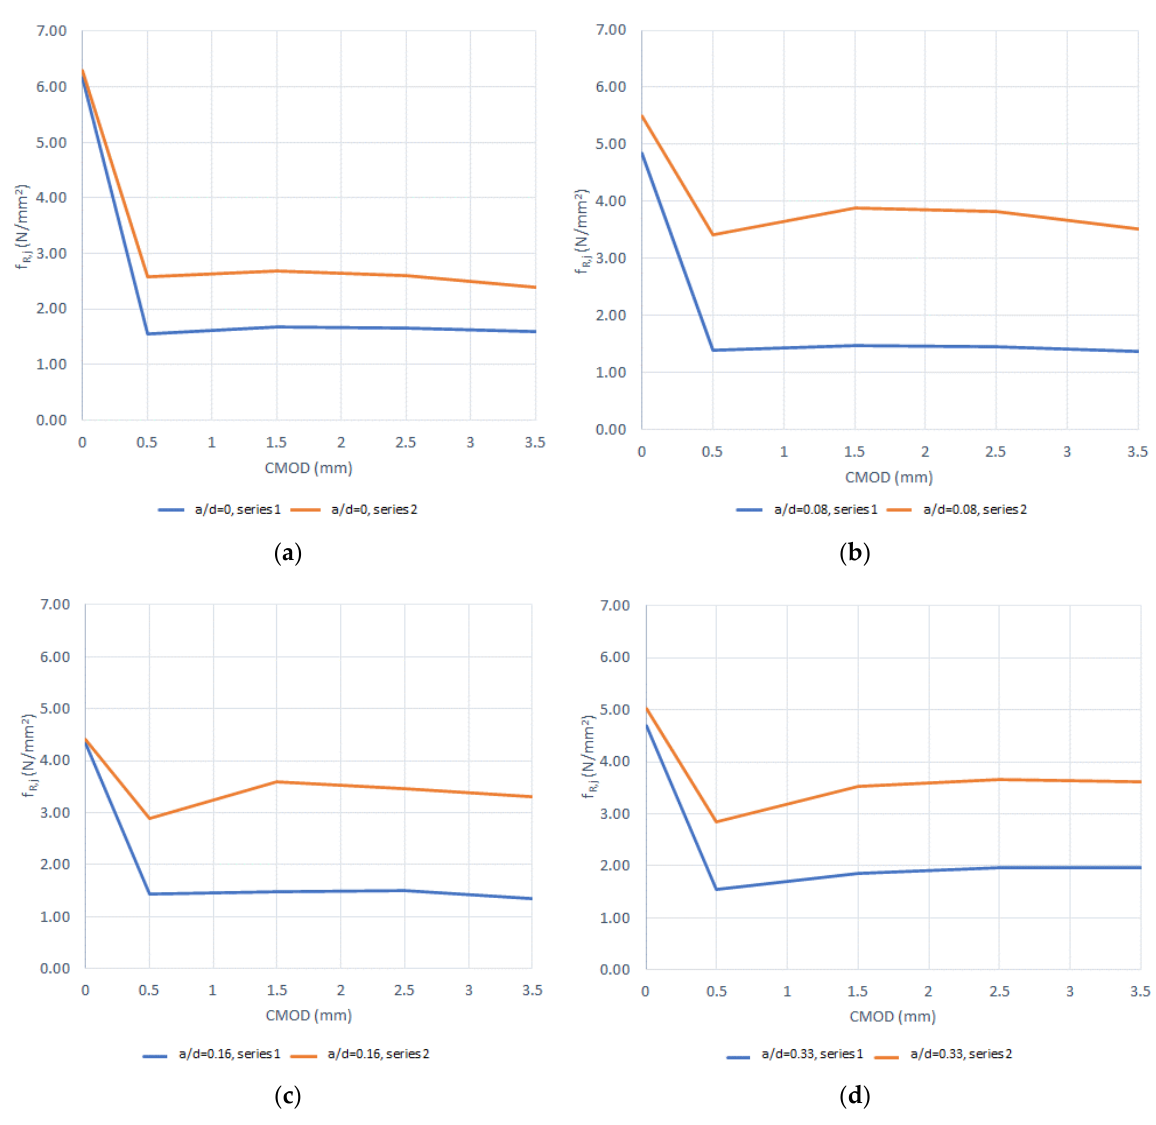
Figure 9. Residual normal stresses for both series with fibers and for each of the studied (a/d) ratios ( a ) 0, ( b ) 0.08, ( c ) 0.16, and ( d ) 0.33.